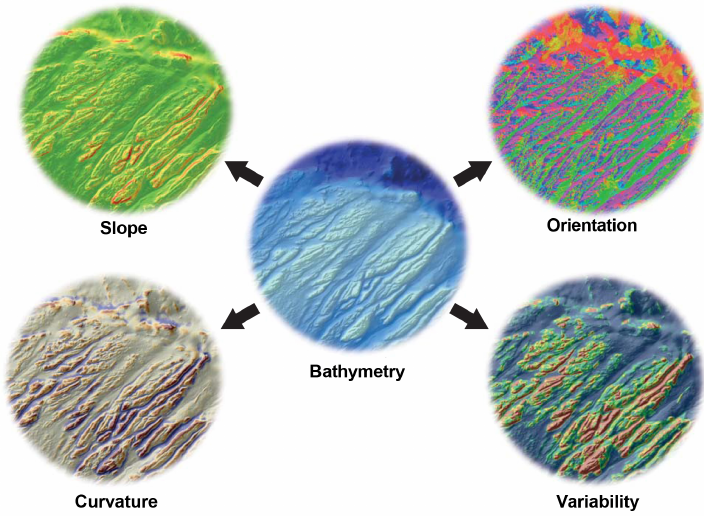
Figure 5. Illustration of the main types of terrain attributes that can be derived from bathymetry data. Modified after Wilson et al.